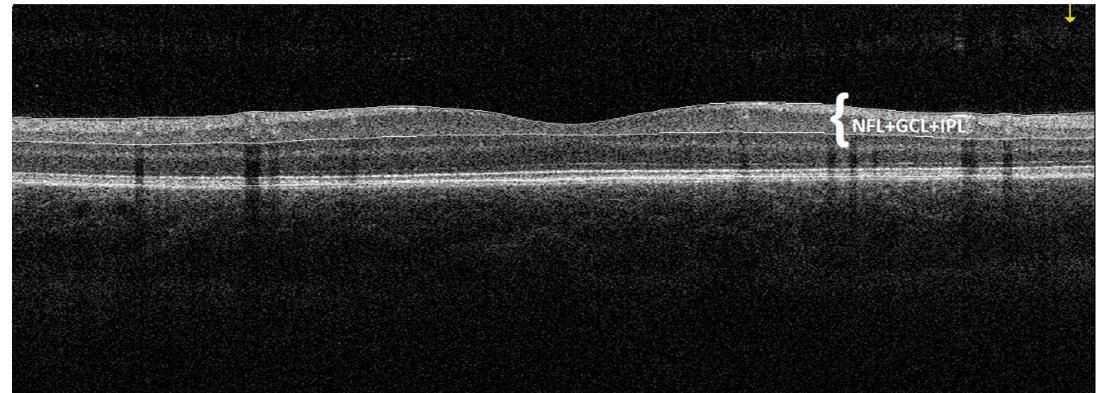
Figure 1. An example of a horizontal macular cross-section of a patient with DCM obtained by OCT. The GCC thickness is automatically measured by the device as the distance between the internal limiting membrane and the outer inner plexiform layer boundary. In the presented figure, three retinal layers such as the ganglion cell layer (GCL), the inner plexiform layer (IPL) and the nerve fibre layer (NFL), which together form a complex of retinal ganglion cells, are marked in white.